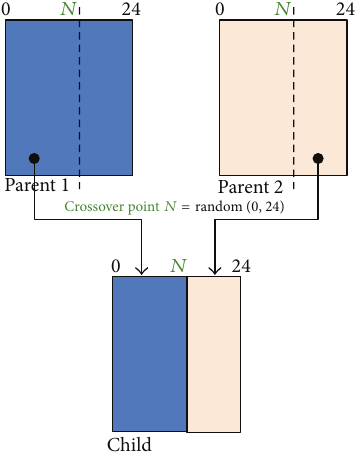
Figure 7: Crossover operations in the proposed scheduling algo-